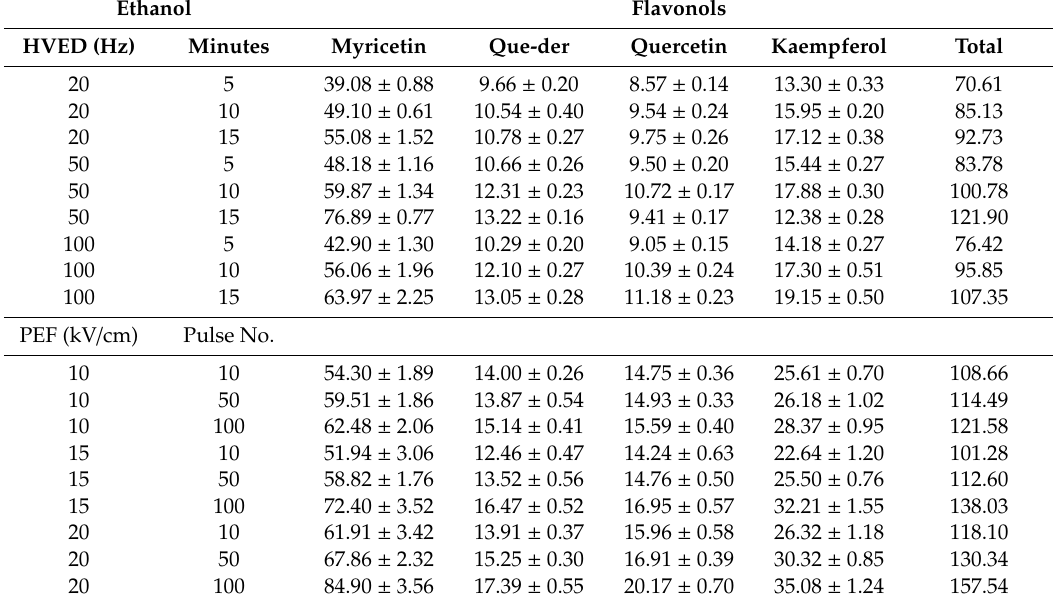
Table 5. Flavonols content ( µ g / g of dw) in the analysed extracts obtained after high voltage electrical discharges (HVED), pulsed electric field (PEF), and ultrasound-assisted extraction (UAE) of blueberry